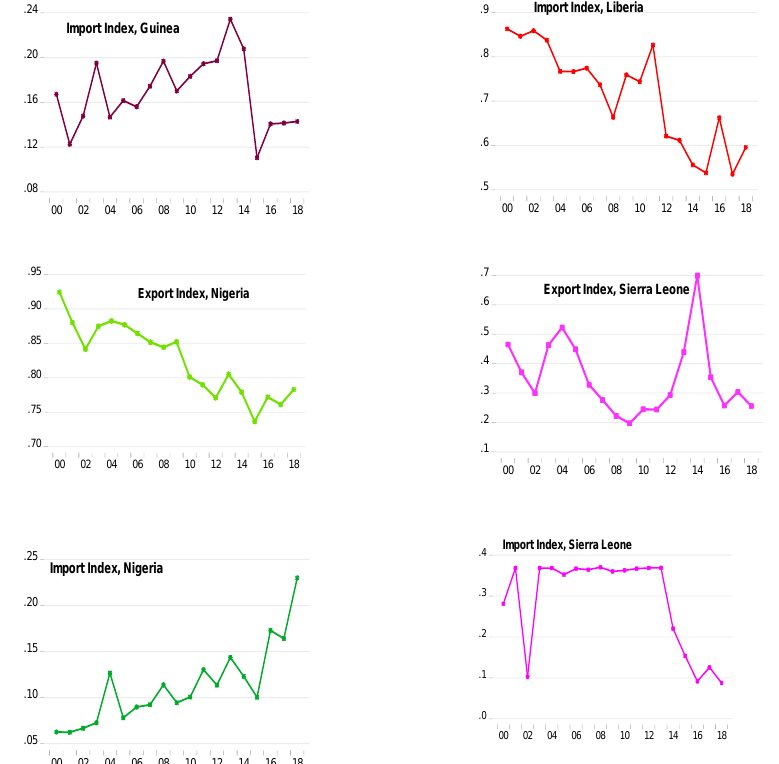
Figure 1 (Cont’d) : Graphical Illustration of Imports and Exports Concentration Index across Countries; Source: Authors Computation, (2020)